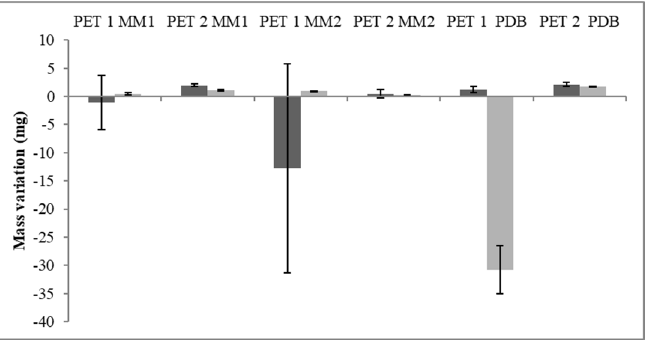
Figure 6. Mass variation of the PET fragments after fermentation. C. cladosporioides CBMAI 2075 (light gray) and T. atroviride CBMAI 2073 (dark gray). Data below the x -axis (negative values) indicate mass gain at the end of the process. Table 6. Lipase and esterase activities in the fermented broth.